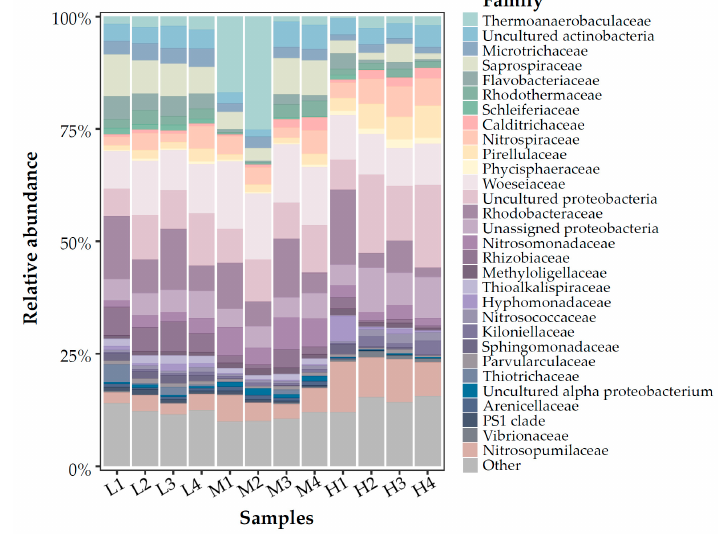
Figure 4. Taxonomic classification at the family level.